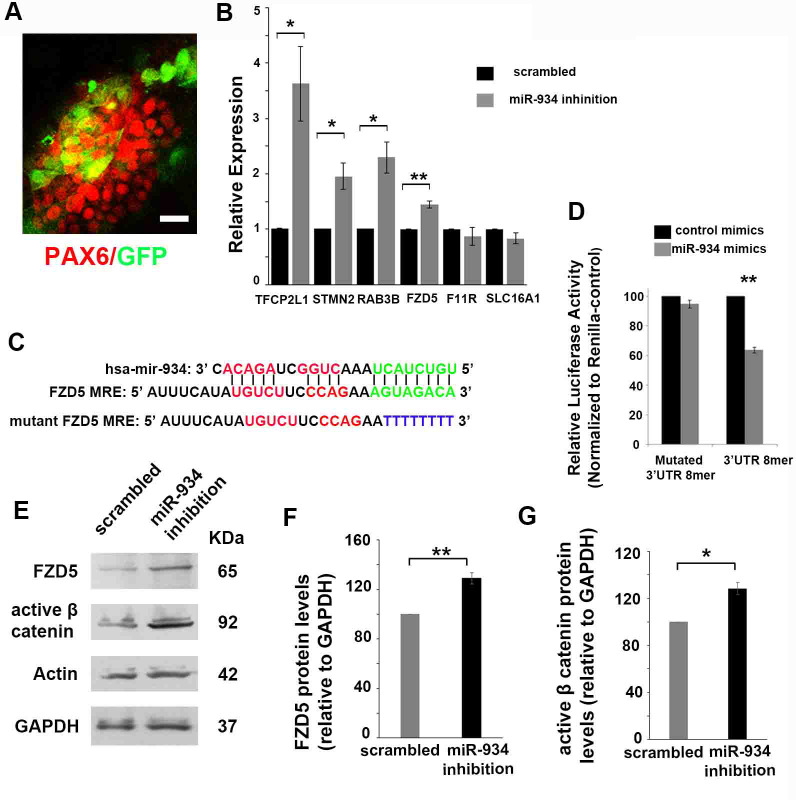
Identification of miR-934 targets during neural induction.(A) Confocal image showing PAX6+ neural progenitors (red) at DIV 15 transduced with miRZip lentivector (GFP fluorescence, green) for sustained inhibition of miR-934. Scale bar: 20 μm. (B) qRT-PCR data showing upregulation of miR-934 targets upon sustained miR-934 inhibition: TFCP2L1 (scrambled control 1+0.006 vs miR934 inhibition 3.63+0.67, p=0.03, n = 4), STMN2 (scrambled control 1+0.003 vs miR934 inhibition 1.95+0.23, p=0.02, n = 4), RAB3B (scrambled control 1+0.003 vs miR934 inhibition 2.29+0.28, p=0.01, n = 4), and FZD5 (scrambled control 1,004+0005 vs miR934 inhibition 1,44+0,061, p=0,005, n = 4). No changes were observed in the mRNA expression of F11R or SLC16A1 (p=0,18 for SLC16A1and p=0,47 for F11R, n = 4). (C) Sequence complementarity of miR-934 with the 8-mer binding site in Fzd5 3'-UTR region (green) and corresponding mutated site (blue), used in luciferase activity assay. (D) Estimation of the suppression of luciferase activity in HEK293T cells upon co-transfection with miR-934 mimics and the MRE (8-mer binding site) reporter construct. Suppression of luciferase activity was released upon mutation of the FZD5 8mer binding site (p=0.002, n = 3). (E–G) Sustained inhibition of miR-934 results in increased protein levels of FZD5 (p=0.007, n = 4) (E, F) and active β-catenin (p=0.01, n = 4) (E, G). Bars and error bars represent mean values and the corresponding SEMs; 0.01<*p<0.05; 0.001<**p<0.01.Figure 4—source data 1.qRT PCR data for expression of miR-934 predicted targets upon sustained miR934 inhibition.Figure 4—source data 2.Data on luciferase activity in HEK293T cells upon co-transfection with miR-934 mimics and the MRE (8-mer binding site) reporter construct.Figure 4—source data 3.Data on western blot results for FZD5 and b-catenin proteins following miR934 Sustained inhibition.